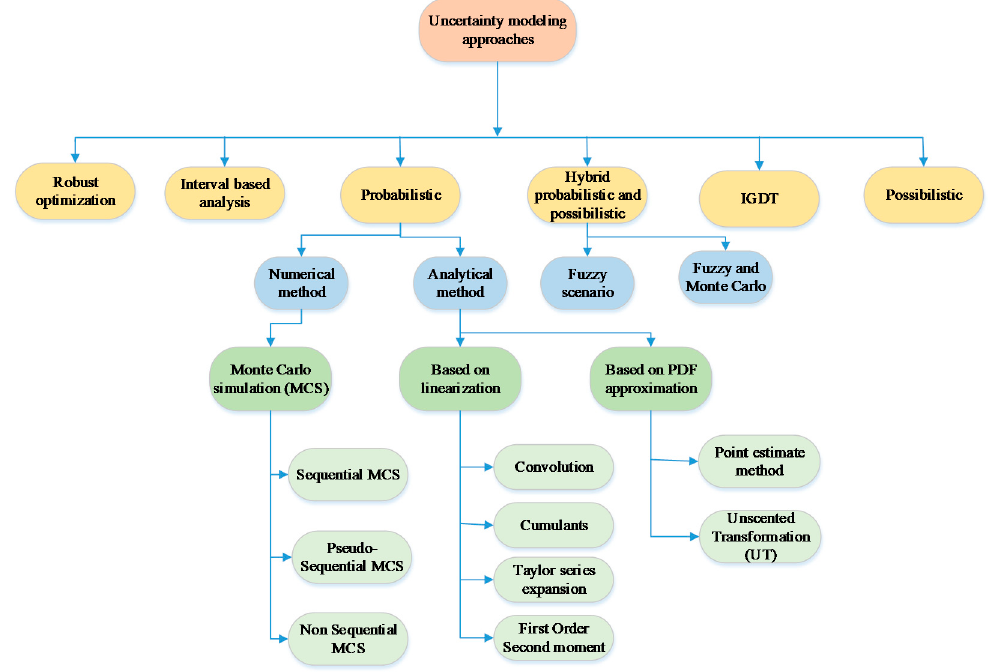
Figure 10. Categorisation of uncertainty modelling techniques